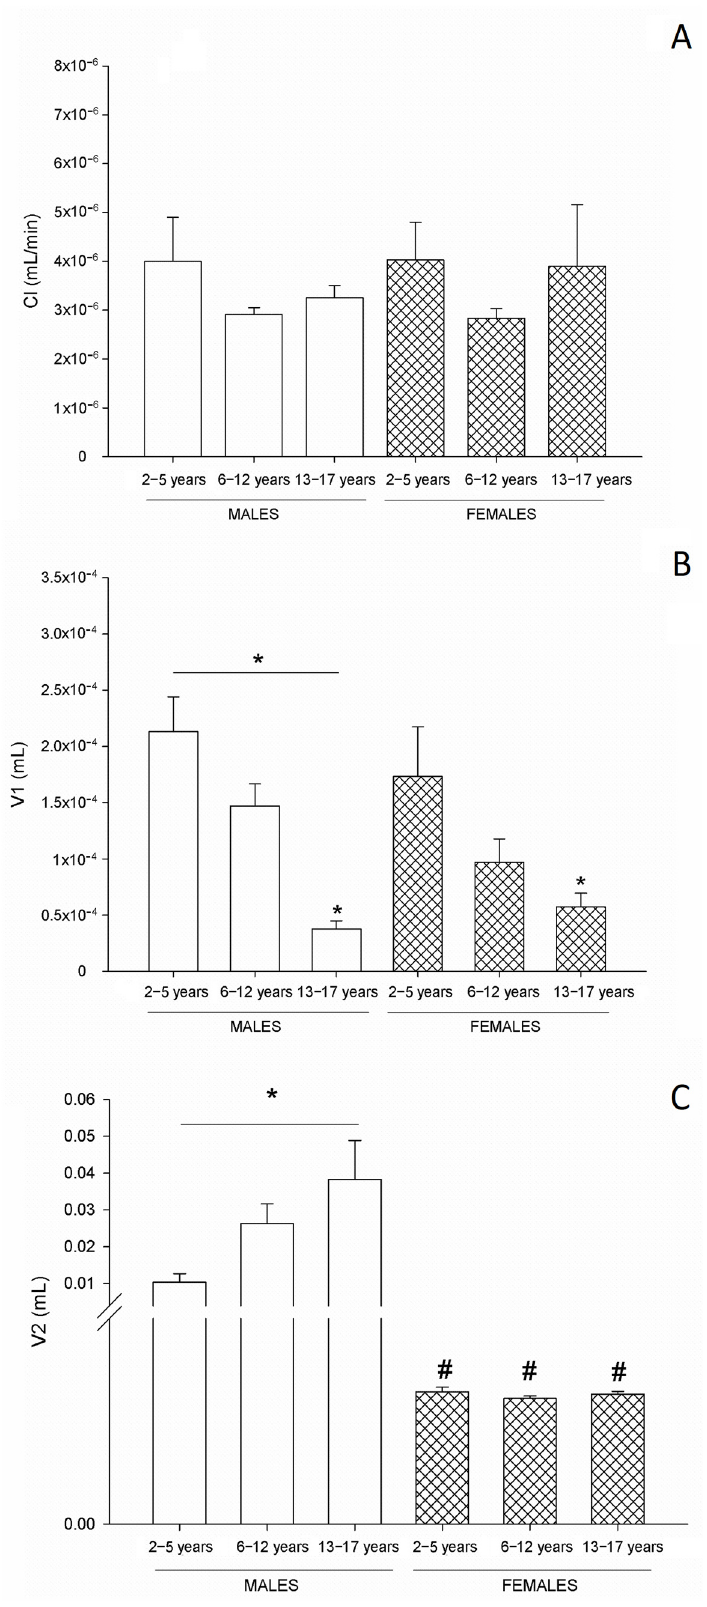
Figure 3. Main pharmacokinetic parameters by age and sex for patients undergoing minor surgeries. The symbol * corresponds to p < 0.05 values according to age range, while the symbol # refers to p < 0.05 values according to sex. Kruskal ‒ Wallis analysis of variance followed by Dunn’s multiple comparisons test.